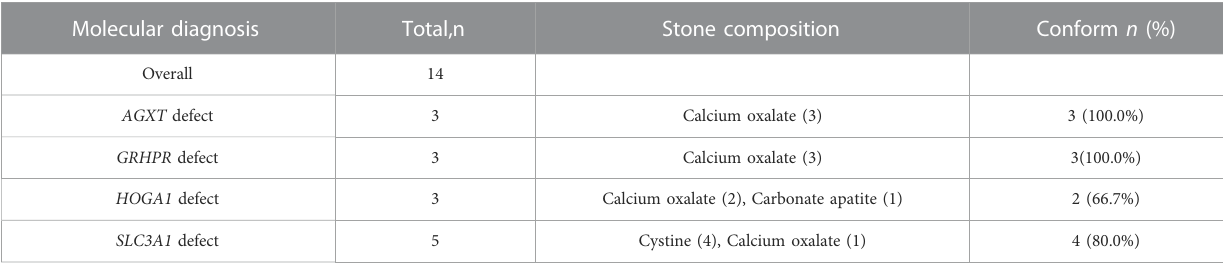
TABLE 6 Conformity between UL-causing genetic mutations and stone composition. Molecular